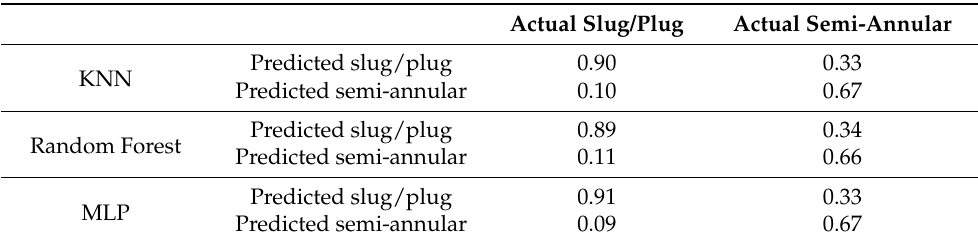
Table 10. Confusion matrix results for